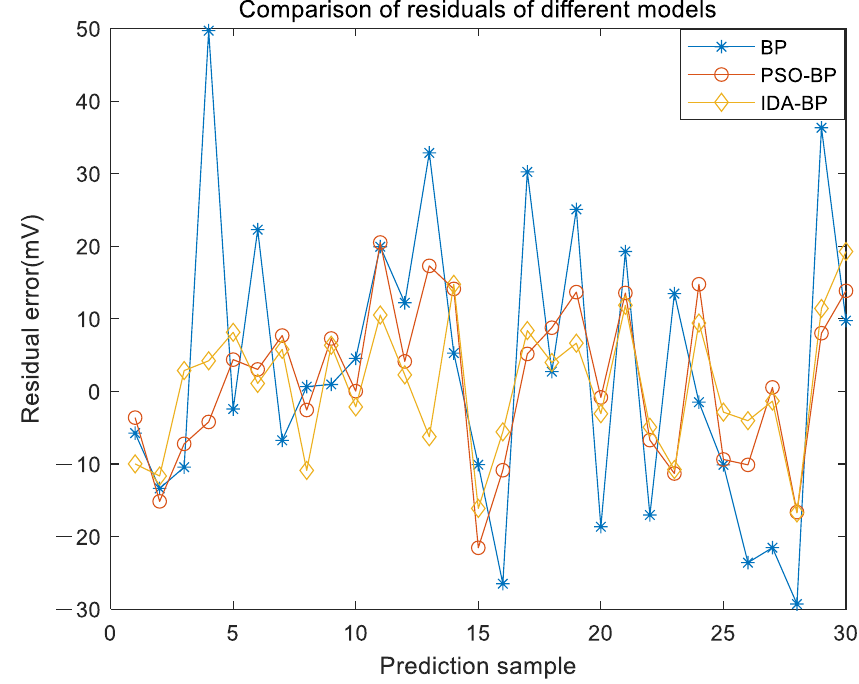
Figure 10. Residual error comparison of three models.